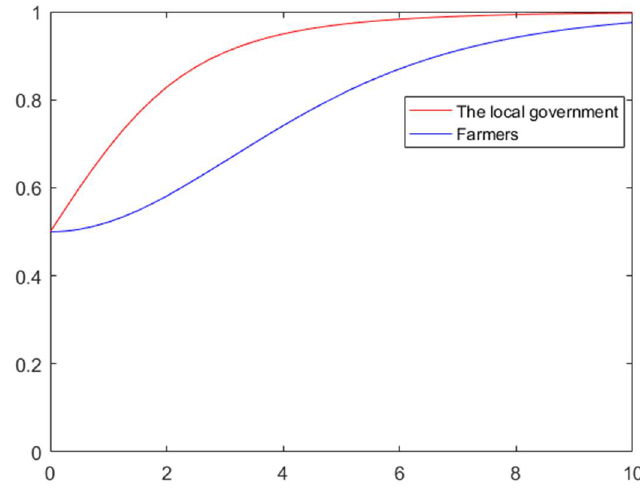
∆ S = 2.5, I = 1, ∆ S = 1.5). 2 4 1